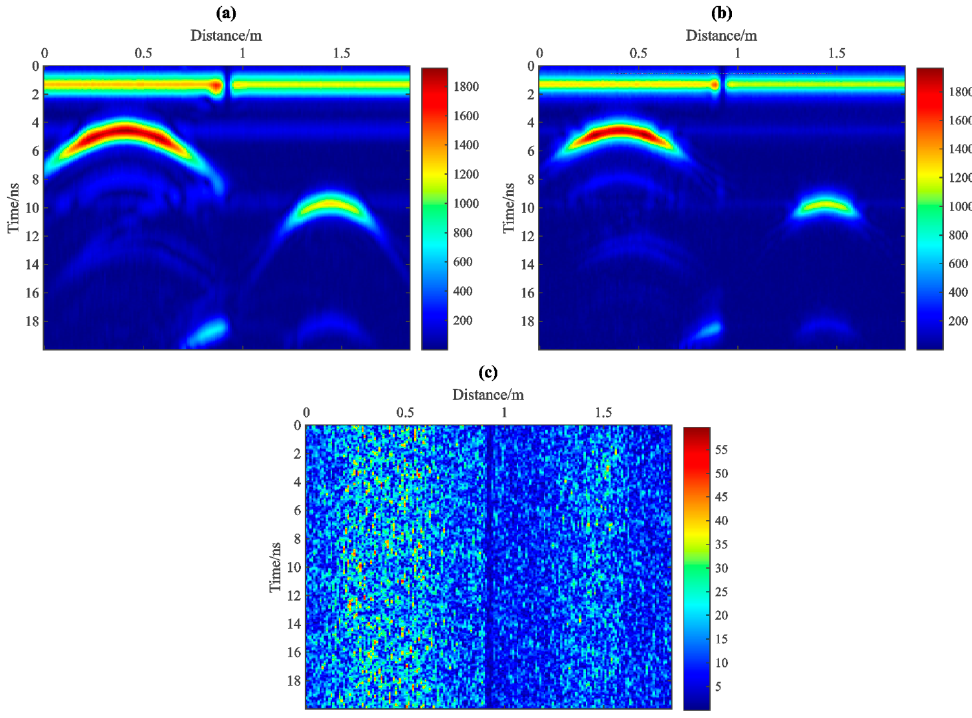
Figure 9. ( a − c ) show the instantaneous amplitude profiles of IMF-slices 1 − 3 for the GPR forward model using MVMD, respectively.